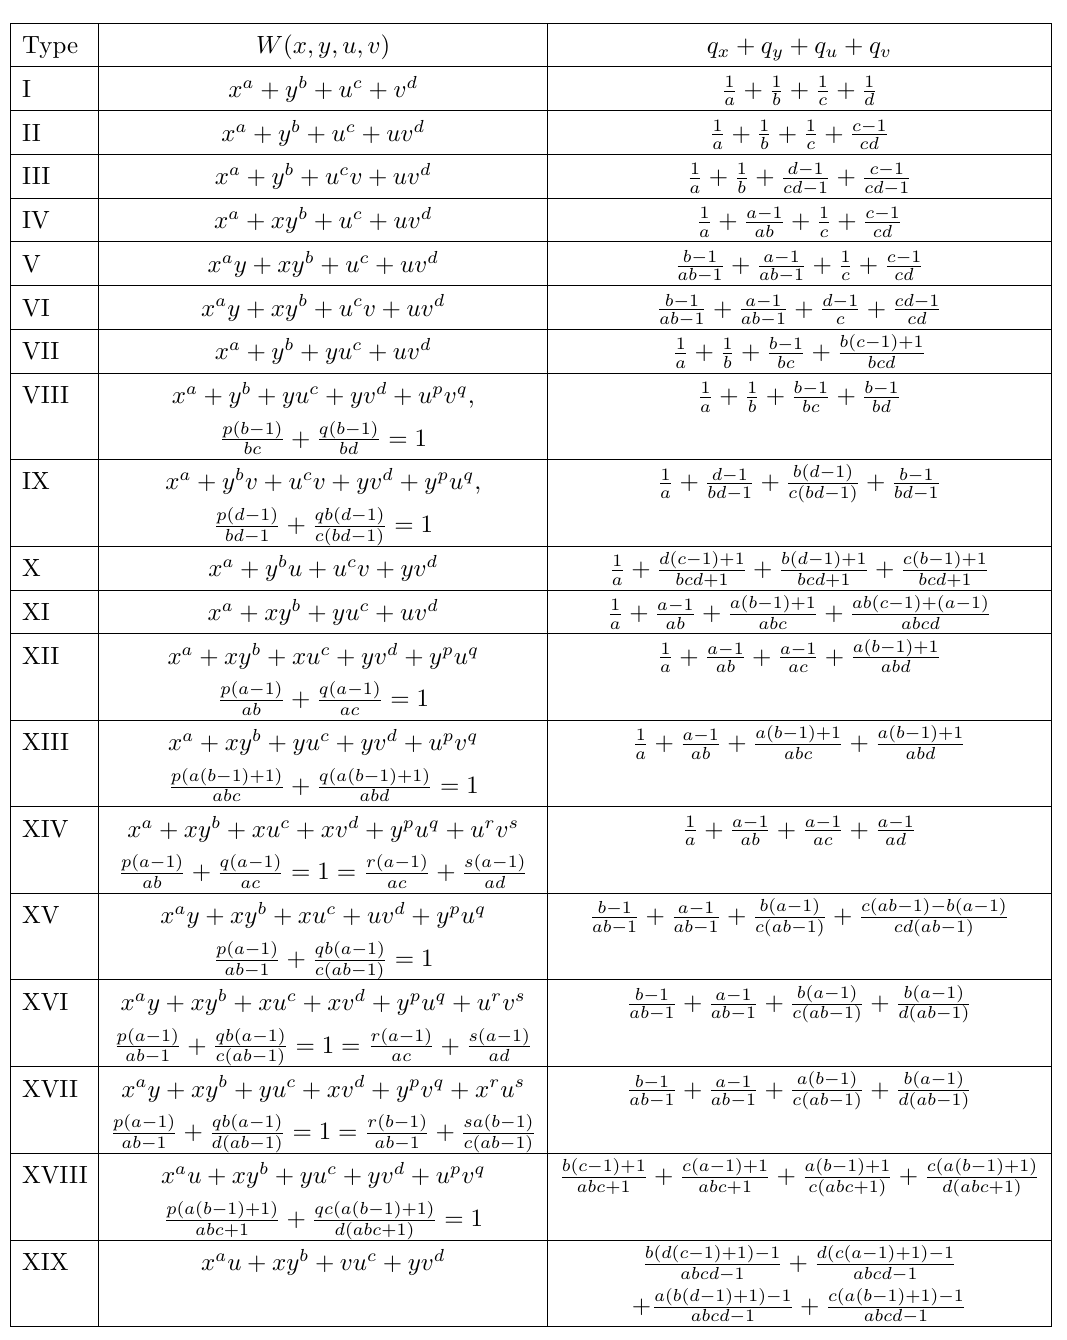
Table 3 . The canonical form for IHSs with a good C ∗ action. This table is adapted from